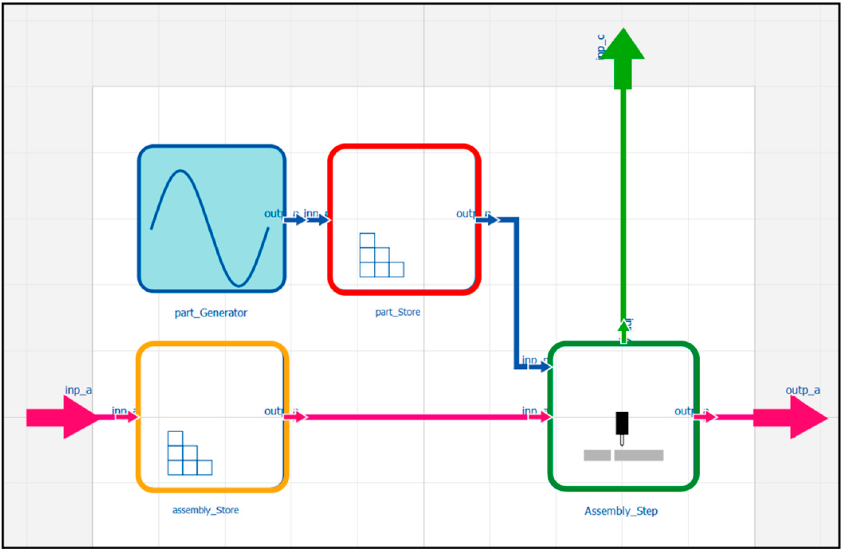
Figure 8. Structure of the AssemblyStep (MachineProcess) block in the OpenModelica graphical interface.